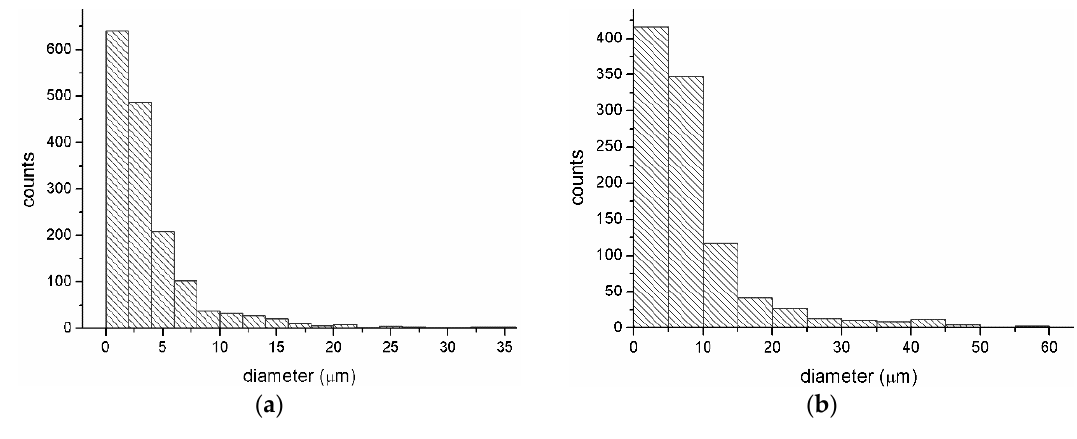
Figure 4. Particle size of ( a ) Biohaloysite and ( b ) SAP.